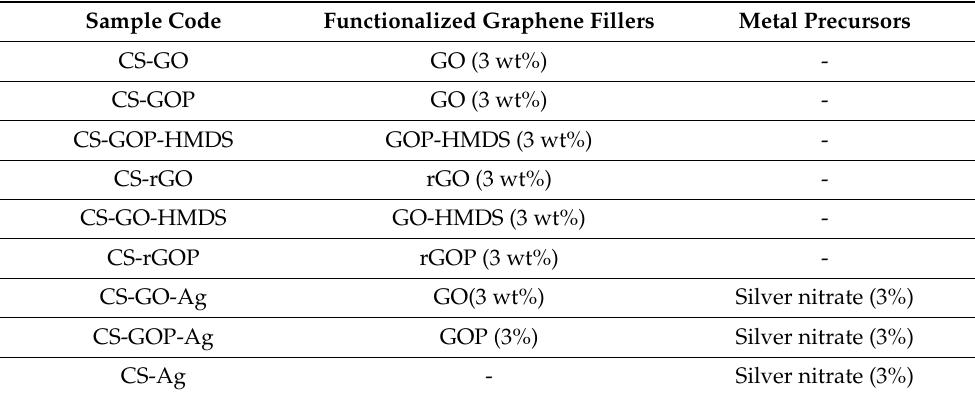
Table 2. Chemical composition of chitosan-graphene